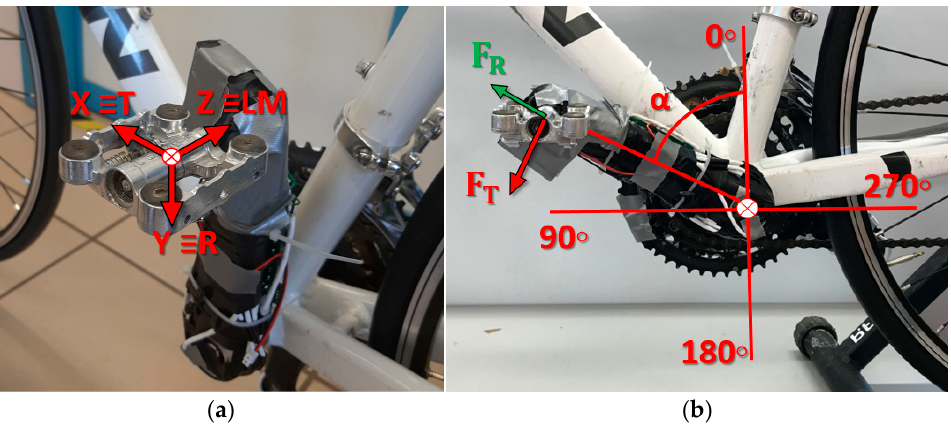
Figure 1. Measurement equipment details. ( a ) Coordinate origin and system. T: tangential direction. R: radial direction. LM: lateral-medial direction. ( b ) Crank rotation angle, α , with respect to a vertical line and forces components F T and F R apply to the pedal.